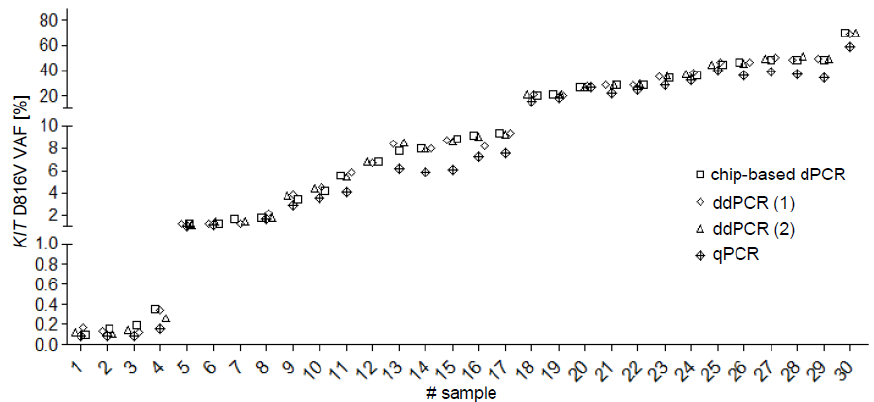
Figure 2. Quantitative assessment of the KIT D816V variant allele fraction (VAF) in 30 samples using various PCR methods. A very good correlation was observed for dPCR vs. ddPCR ( r = 0.99, R 2 = 0.99) and for dPCR vs. qPCR ( r = 0.99, R 2 = 0.98). dPCR, digital PCR; (1) ddPCR, droplet digital PCR from laboratory A; (2) ddPCR droplet digital PCR from laboratory B; qPCR, genomic quantitative real-time PCR.